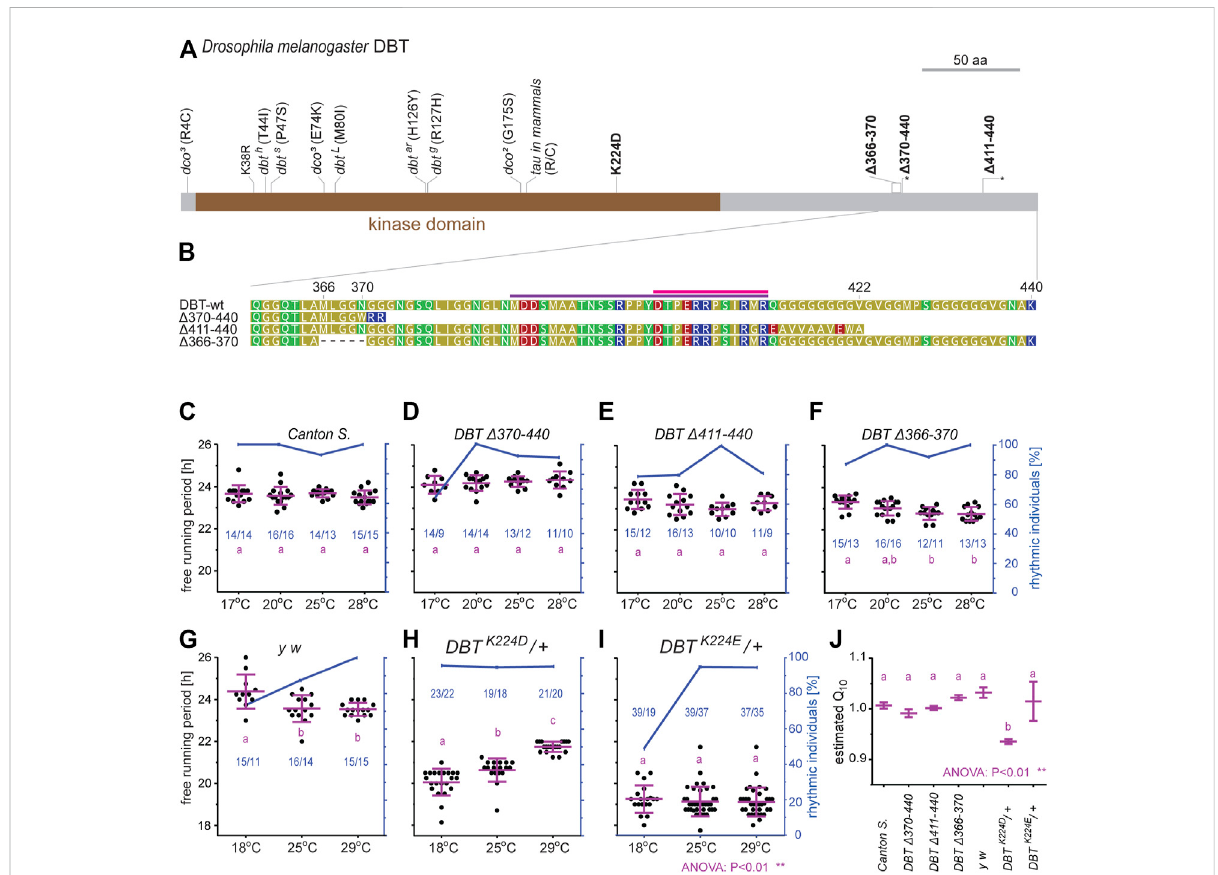
FIGURE 8 Functional analysis of new dbt mutants created in D.melanogaster . (A) A schematic depiction of DBT proteinwith highlightedmutations; here- createdmutantsareinbold,theasteriskintheschemereferstoaprematureproteinterminationduetoaframeshift. (B) DetailoftheC-terminaltailin the wild type (wt) and three mutant lines. The dipteran and cyclorrhaphan motifs are highlighted by light and deep purple, respectively. (C – I) Circadian clockphenotype[each dotin panels (C – I) represents thefree-running period tau, τ , ofindividual male fl ies] was recorded for 10 days inDDatthespeci fi edtemperature.Bluedotsconnectedwithabluelineindicatethepercentageofrhythmicindividualsataparticulartemperature.A scale indicating the percentage rhythmicity is on the right y-axis, the blue numbers in the chart represented n total /n rhythmic . (J) The temperature compensation depicted as Q 10 was calculated from data presented in (C – I) . Magenta bars represent means ±